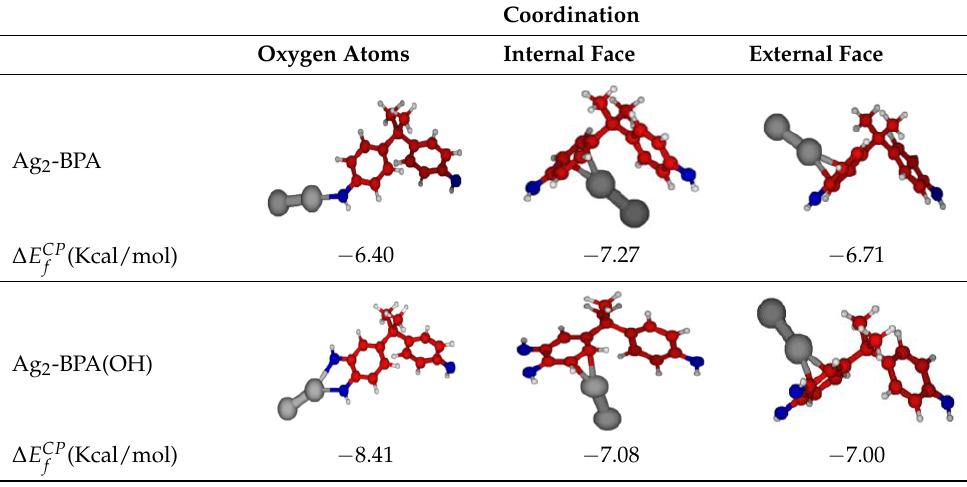
Table 1. Optimized structures of Ag 2 -BPA and Ag 2 -BPA(OH) complexes and their complexation energy.